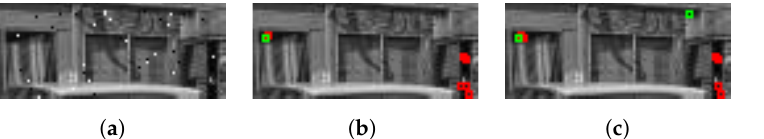
Figure 14. Zoom of a region of the original image taken from tthe Linnaeus 5 dataset [32] with false positive and false negative examples: ( a ) Noisy image. ( b ) Results of proposed algorithm. ( c ) Circuit